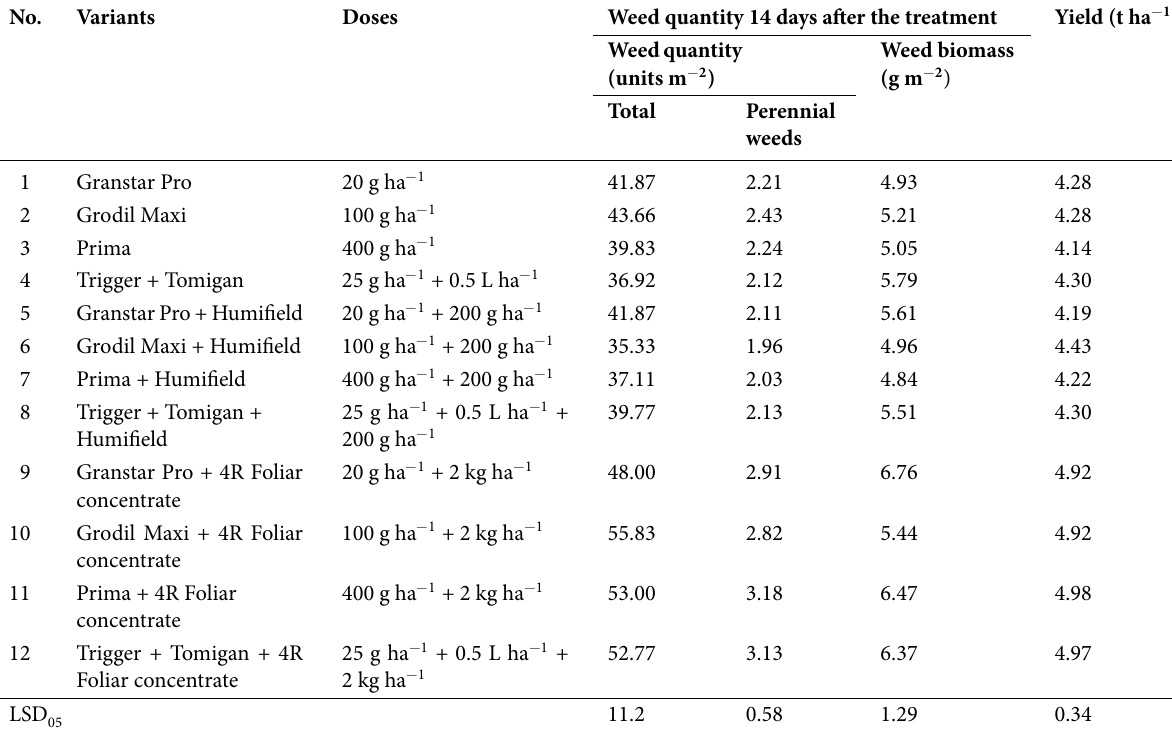
Table 2 e effects of the herbicides, and their mixtures with humic growth regulators, on the weed density and winter wheat yield of the ‘Kryzhynka’